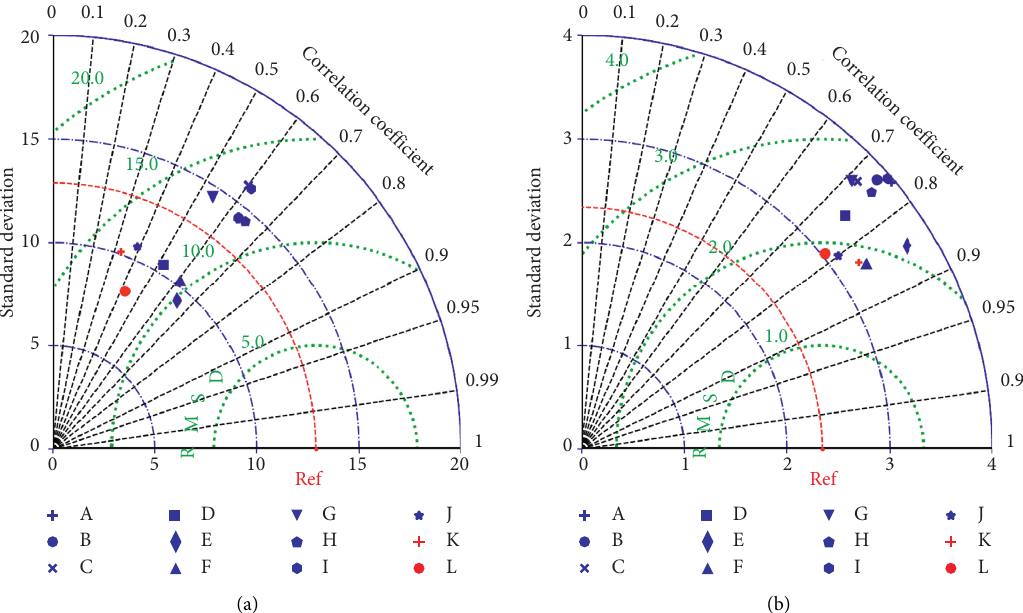
Figure 9: Taylor diagrams with standard deviation, correlation coefficient, and RMSD for each ensemble member for the whole country of Lao PDR. (a) Wet whole country; (b) dry whole